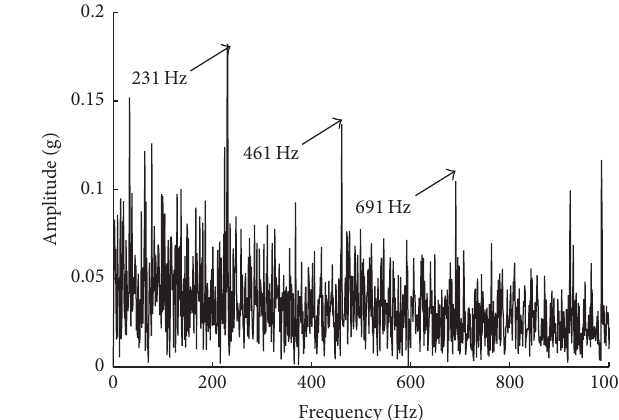
Figure 13: Demodulation result of the 533rd sample.